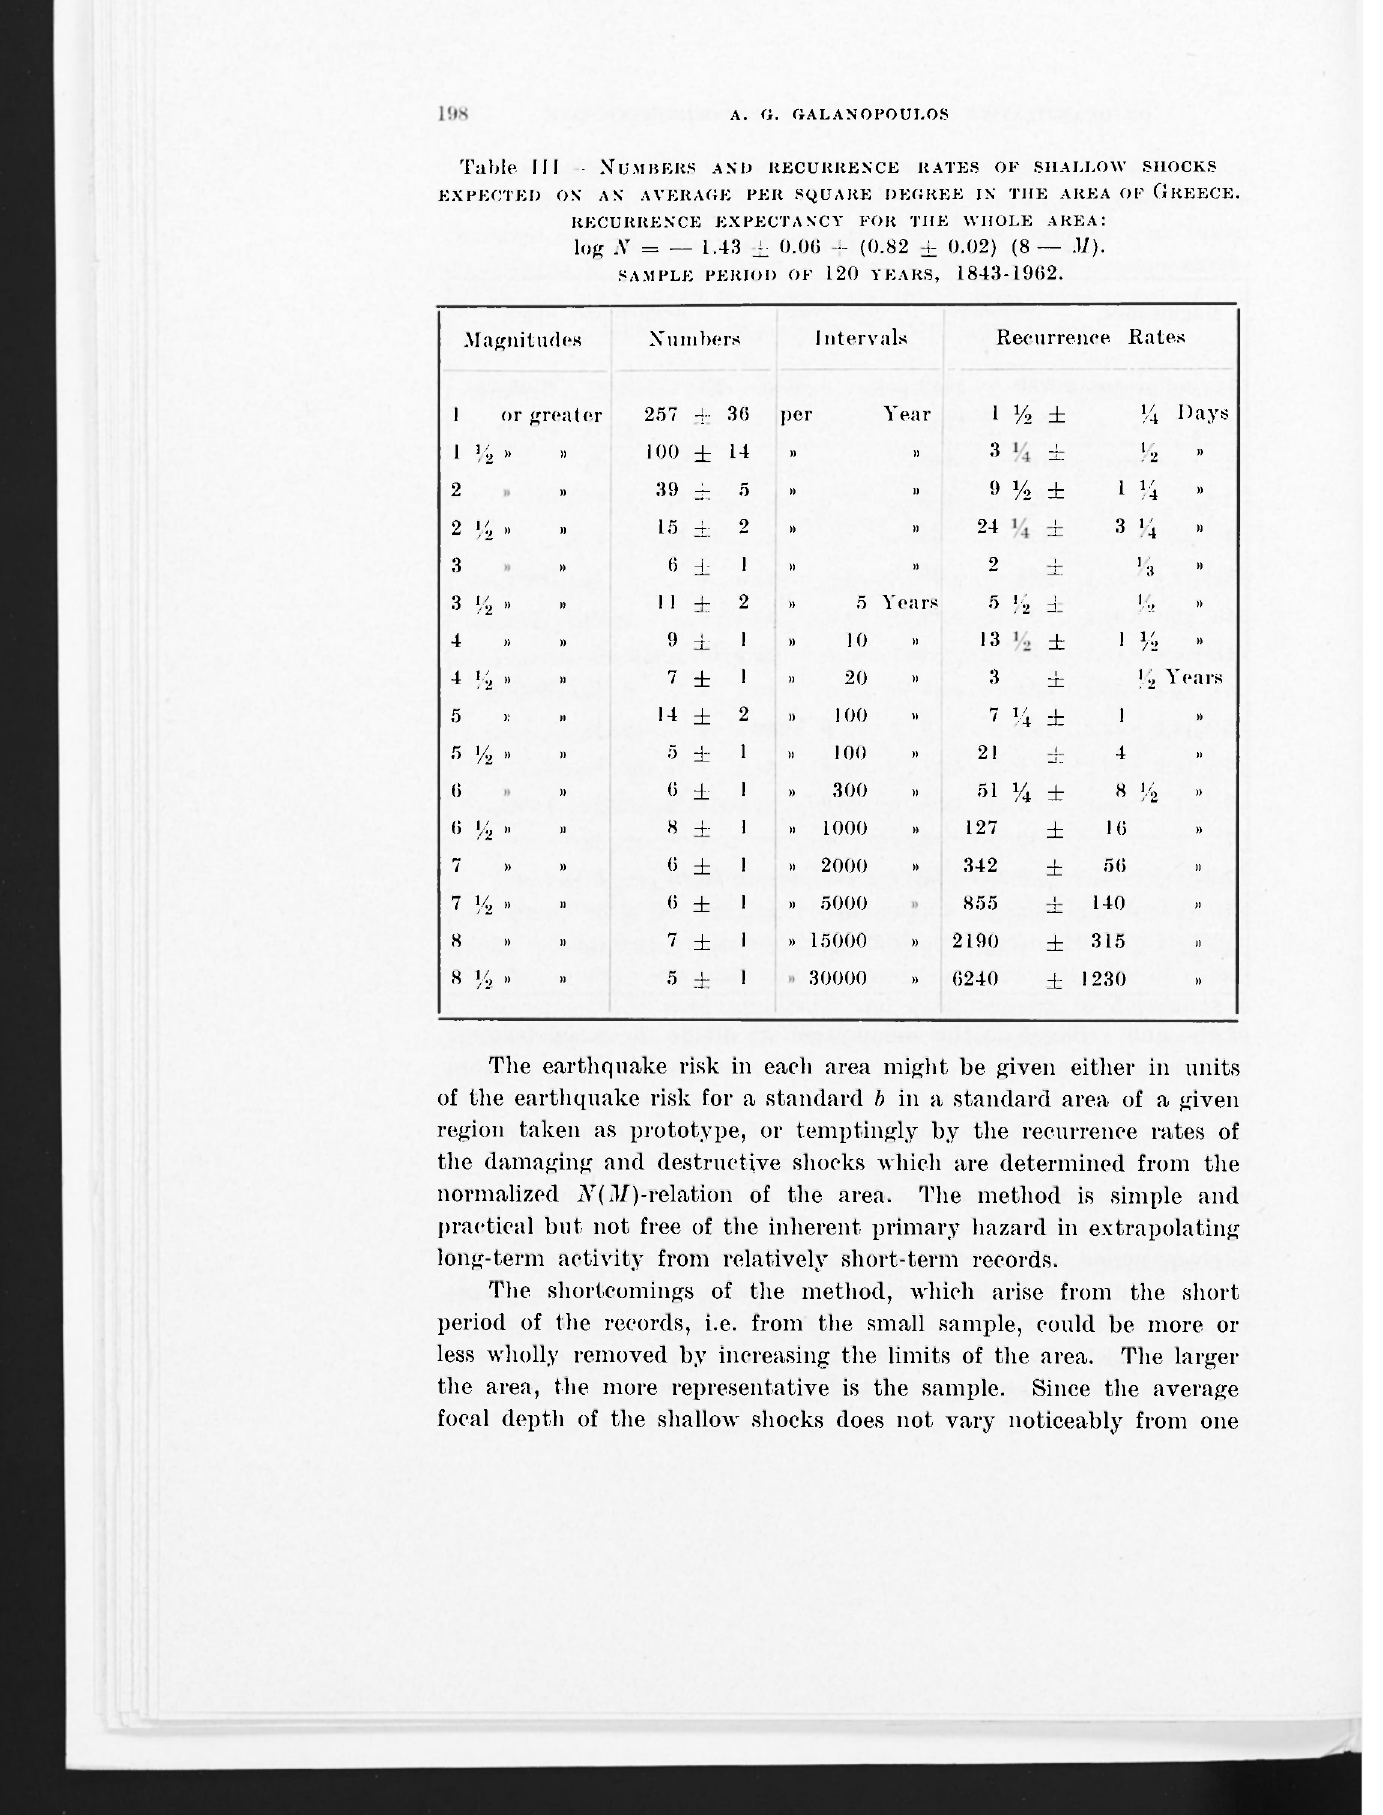
NUMBERS AND RECURRENCE RATES OF SHALLOW SHOCKS EXPECTED ON AN AVERAGE PER SQUARE DEGREE IN THE AREA OF